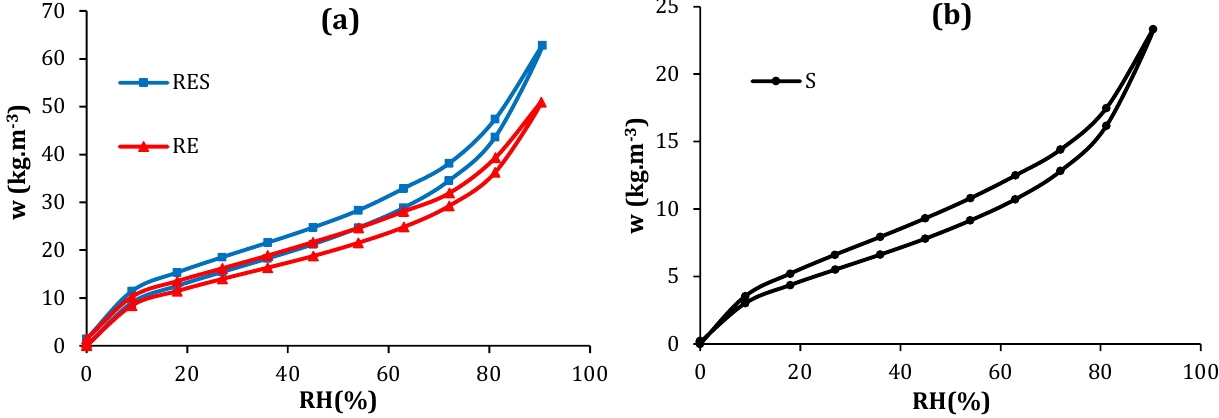
Figure 11. Comparison of cob’s volumetric heat capacity with different materials.